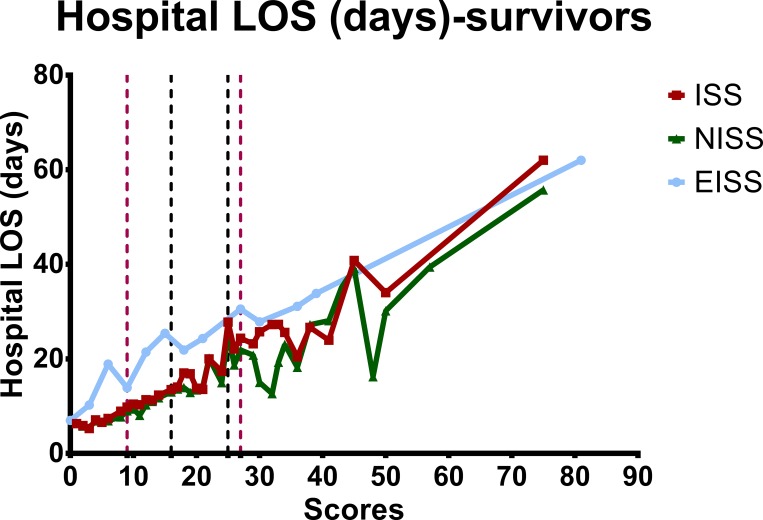
The hospital LOS-to-severity score relationships for survivors classified according to the ISS, NISS, and EISS.